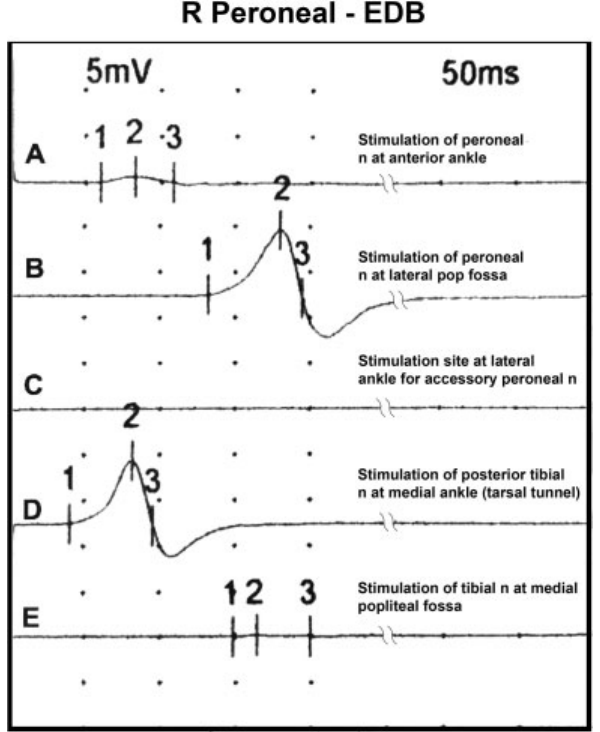
Fig. 1 Compound muscle action potential (CMAP) of the extensor digitorum brevis (EDB) stimulating from various points on the foreleg. Normally the amplitude of the CMAP of the EDB obtained by stimu- lation of the deep peroneal nerve at the ankle would be equal to that obtained by stimulation at the popliteal fossa, that is, trace A would equal with B. With a deep peroneal to posterior tibial anastomosis, a response is elicited by stimulating the posttibial nerve at the medial ankle (trace D). If there was an accessory deep peroneal nerve contribution, trace C would have a response. Proximal tibial stimu- lation would elicit a robust response in trace E in an “ all tibial foot.